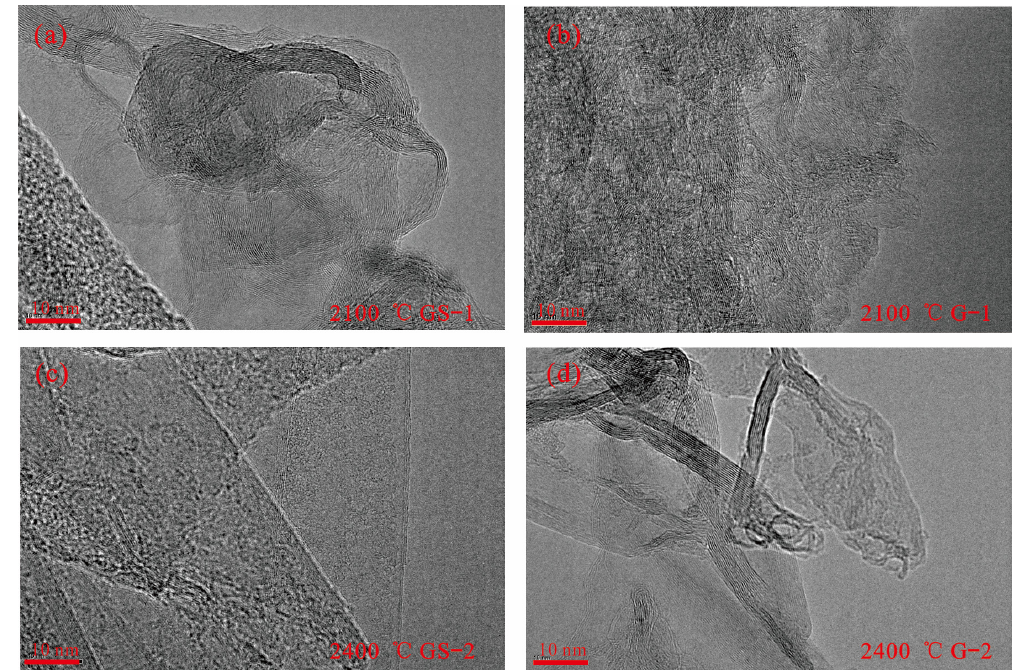
Minerals 2022 , 12 , 1239 10 of 19